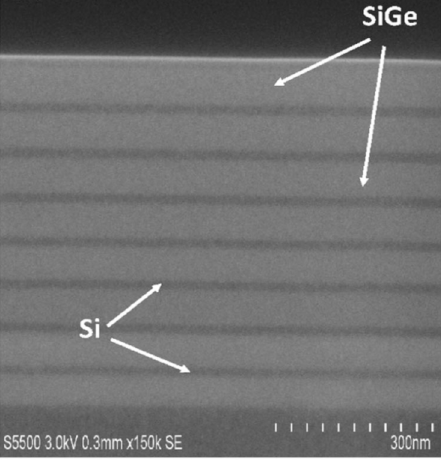
Figure 12. HRSEM of a multilayer of the SiGe/Si structure with eight periods [66].